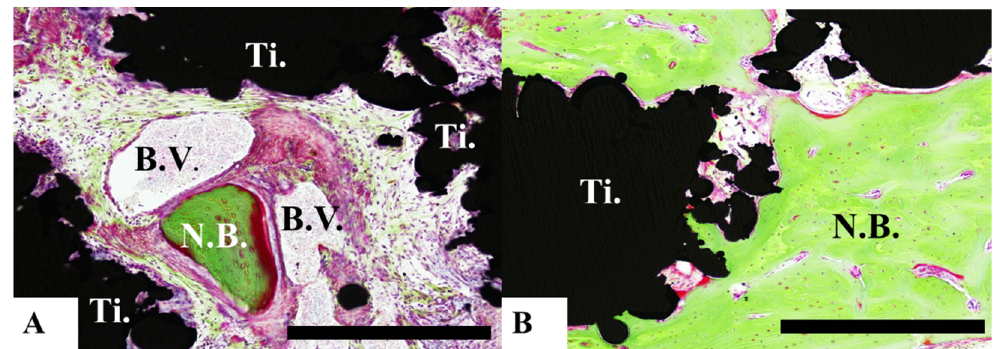
Figure 8. Histological analysis of mixed-acid and heat-treated porous additive-manufacturing titanium artificial bones (pAMTABs) at 16 weeks. ( A ): Blood vessels around newly formed bone and pAMTAB. ( B ): Active bone formation is observed partially. Scale bar indicates 100 µ m. Ti: pAMTAB; Bo: calvarial bone; B.V.: blood vessels.